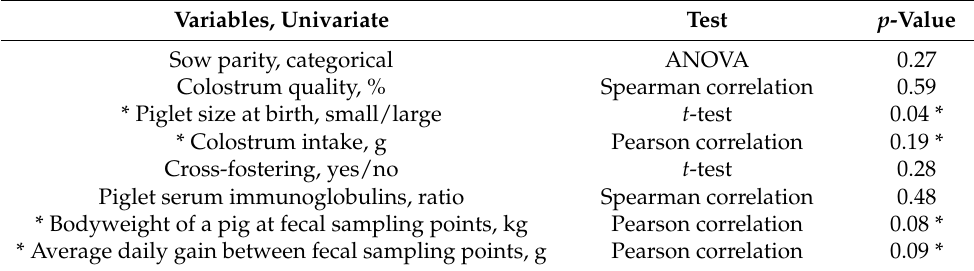
Table 1. Testing of factors associated with total lactobacilli count (CFU/mL) in the fecal samples of growing pigs, univariate analysis. * Variables with a p -value < 0.25 were tested in the multivariable analysis. Variables, Univariate Test p -Value Sow parity, categorical ANOVA 0.27 Colostrum quality, % Spearman correlation 0.59 * Piglet size at birth, small/large t -test 0.04 * * Colostrum intake, g Pearson correlation 0.19 * Cross-fostering, yes/no t -test 0.28 Piglet serum immunoglobulins, ratio Spearman correlation 0.48 Pearson correlation 0.08 * Pearson correlation 0.09